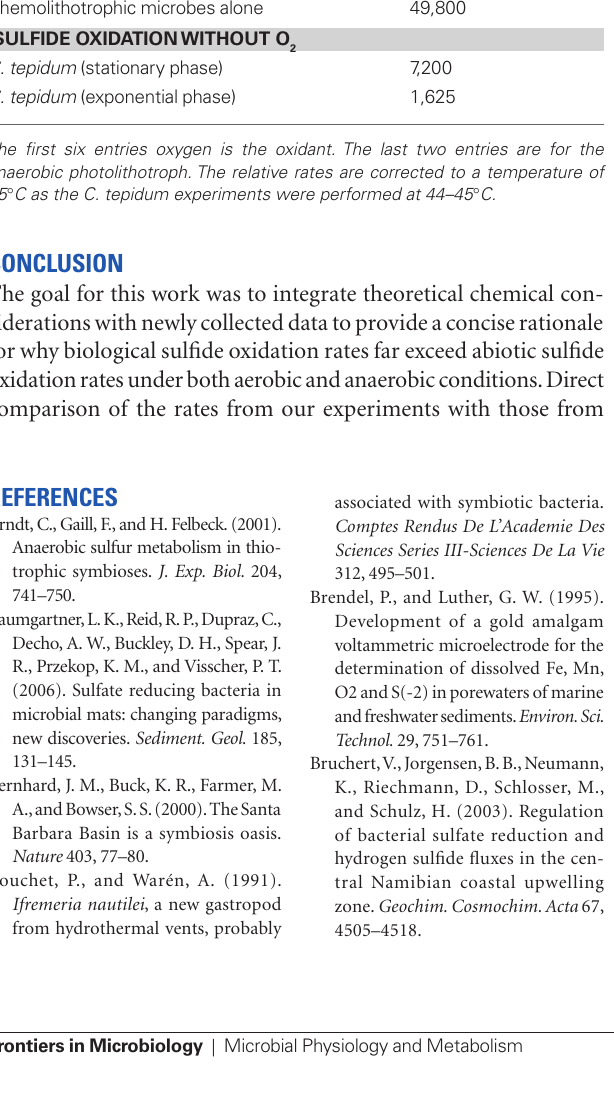
S with O in high-pressure incubation chambers by free-living microbial communities 2 2